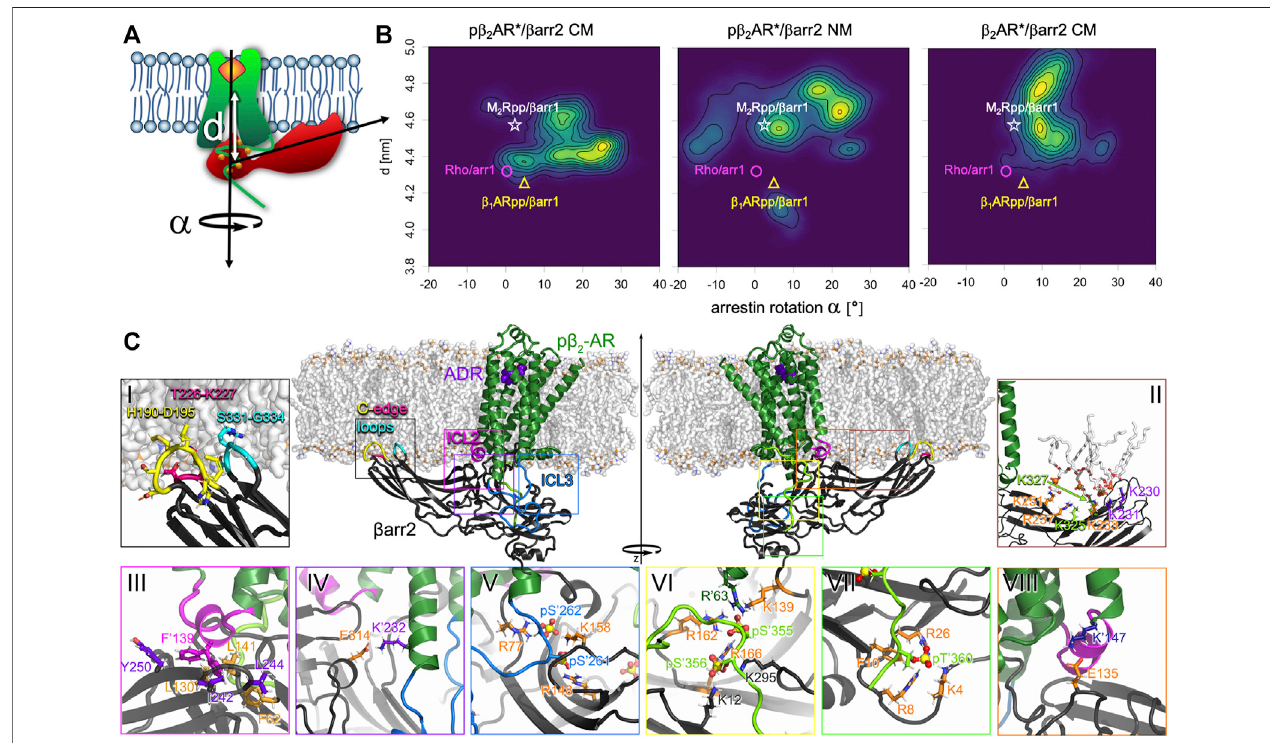
FIGURE4| Phosphorylationand membrane compositionin fl uencebindingorientation of β arr2relativeto(p) β 2 AR*. (A) De fi nitionofbindingcharacteristics usedto describe arrestin binding distance d (vertical distance between the center of mass of the transmembrane helix bundle of the receptor and of the center of mass of the upper 4 beta sheets in arrestin ’ s N-lobe) and arrestin rotation α around the membrane normal relative to the arrestin orientation in the rhodopsin/arrestin-1 complex. (B) 2D densities of the binding distance d and arrestin rotation α of phosphorylated activated p β 2 AR*/ β arr2 complex in the charged (CM) and neutral membrane (NM) and of nonphosphorylated activated β 2 AR*/ β arr2 complex in the CM. For comparison d and α were evaluated for experimentally resolved structures of M 2 Rpp/ β arr1 (Staus et al., 2020) (white star), rhodopsin/arrestin-1 (Zhou et al., 2016) (magenta circle), and β 1 ARpp/ β arr1 (Lee et al., 2020) (yellow triangle). (C) Key interactions of the p β 2 AR*/ β arr2 complex. Side views of the adrenaline-bound (purple spheres) p β 2 AR* (green cartoon with ICL2 in magenta, ICL3 in blue and C-terminus in light green) embedded in a charged membrane (white sticks) in complex with β arr2 (black cartoon with membrane inserted C-edge loops in yellow, hotpink, and cyan). The insets show the interactions between β arr2 and p β 2 AR* and β arr2 and the membrane which were most often observed in the simulations. Receptor residues are marked with an apostrophe ( ‘ ) to distinguish them from arrestin residues. Phosphates are shown as spheres with yellow phosphorus and red oxygen atoms. Residues of interest are shown as sticks with differently colored carbons (for sake of better visibility) and atom-type coded nitrogen (blue), oxygen (red), hydrogen (white), and sulphur (golden). Inset (i) : Arrestin ’ s C-edge loops H190-D195 (yellow), T226-K227 (hotpink) and S331-G334 (cyan) protrude deep into the membrane. Inset (ii) : DOPG lipids (shown as white sticks with orange phosphates and red oxygens) bind to the highly electropositive well of arrestin ’ s C-lobe. Residues experimentally determined to bind phosphatidylinositol lipids (Gaidarovet al.,1999) and hexakisphosphate (Milano et al.,2006) (K233,R237,K251) are coloredorange, twoadditional residues (K325 and K327) knowntobind hexakisphosphate(Milanoet al., 2006)are colored green, and twofurther lysines(K230 and K231) detectedhere asadditional interaction partners of DOPG are colored purple. Inset (iii) : F ’ 139 (magenta) in the ICL2 of the p β 2 AR* inserts into the crevice between the N- and C-lobe of arrestin, interacting mainly with Y250,I242,L244(purple),andL130,L141andF62(orange).TwopossiblepositionsofF ′ 139areshown.Inset (iv) :SaltbridgeformedbetweenK ′ 232(purple)onTM5of thereceptorandE314(orange)ofthearrestin.Inset (v) :ThephosphorylatedresiduespS ′ 262andpS ′ 261(bluesticks)ofthereceptor ’ sICL3(bluecartoon)ofteninteract withthepositivelychargedaminoacidsonarrestin,hereR77,K158andR148(orange).Inset (vi) :PhosphorylatedresiduespS ′ 355andpS ′ 356ontheC-terminusofthe receptor (green backbone) are forming salt bridges witha number ofpositivelycharged amino acids. Here, pS ′ 356 interacts withK12, K295 (black), and R166 (orange). LatterisalsoboundtopS ′ 356,whichfurtherinteractswithR162,K139 (orange) inarrestin and R ′ 63(dark green) onthe receptor ’ sICL1. Inset (vii) : Thephosphorylated pT ′ 360 (green) is involved in a number of salt bridges, here with K4, R8, and R26 (orange). Moreover, it exerts a large force on F10 (orange sticks). Inset (viii) : The salt bridge between K ′ 147 (dark blue) from the intracellular end of TM3 and E135 (orange) in the middle loop of arrestin.